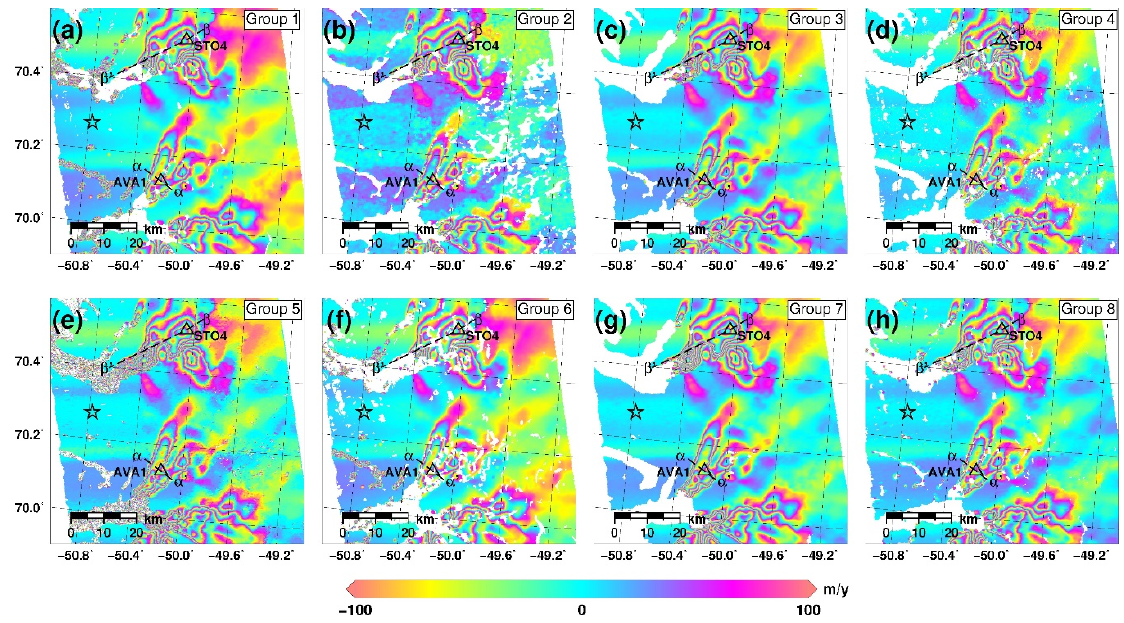
Figure 23. Task 4 wrapped azimuth velocity maps provided by groups 1 to 8 ( a – h ) in the area of GPS stations STO4 and AVA1. Each color cycle represents a 200 m/y variation. Velocities are referred to the star (zero velocity).